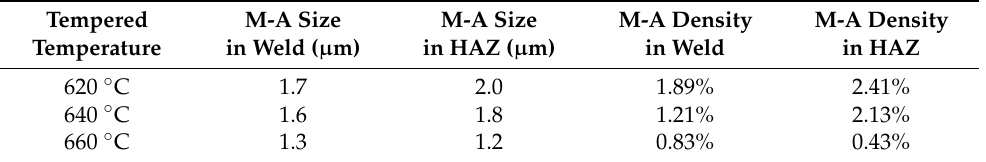
Table 6. M-A constituent size and density for tempering at 620 ◦ C, 640 ◦ C and 660 ◦ C.